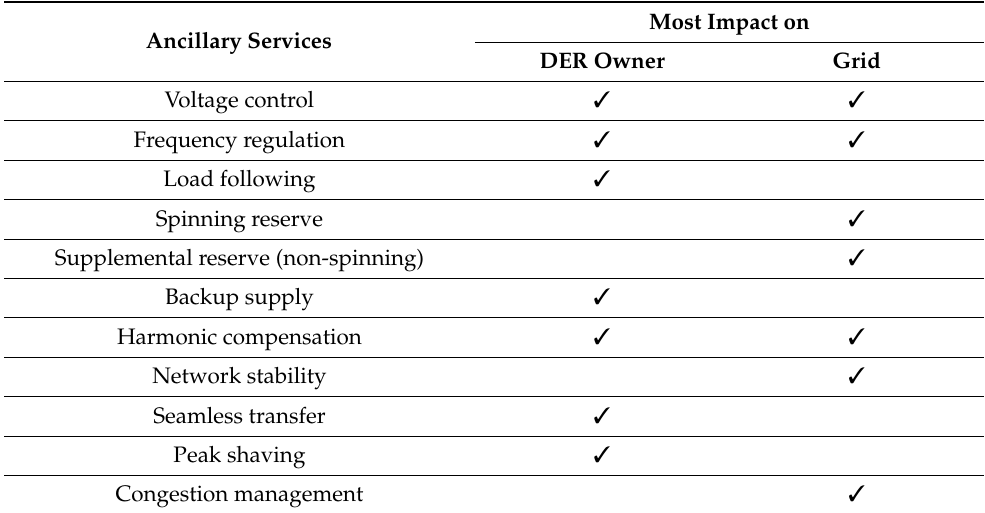
Table 6. Ancillary services and their most beneficial impact [59]. Ancillary